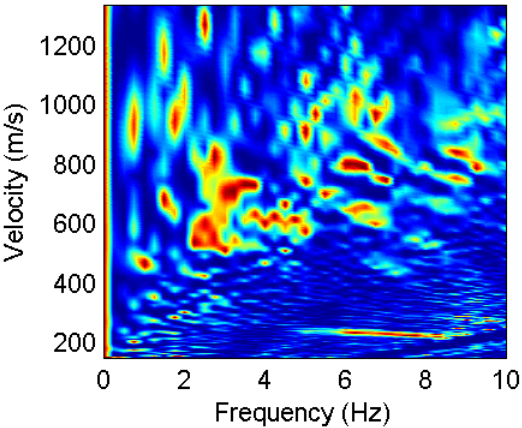
Figure 13. ( a ) An image of dispersive energy of the extracted surface waves using the proposed method and ( b ) dispersion curves picked from Figure 13a.